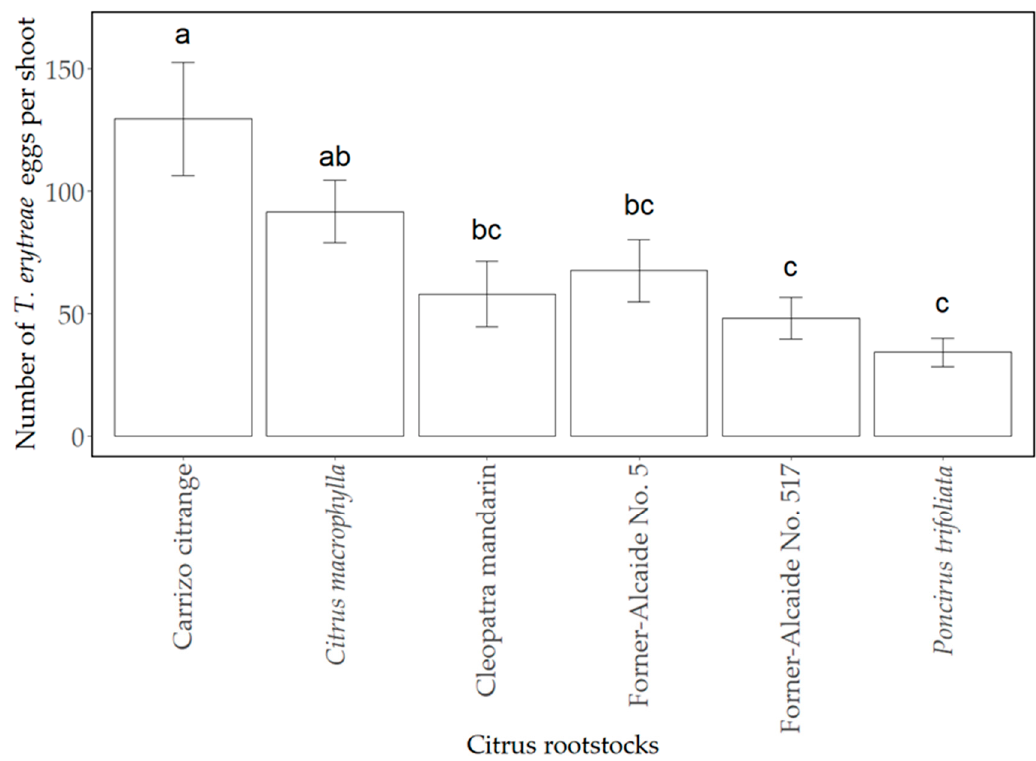
Figure 2. Mean of T. erytreae eggs per shoot ± standard error (SE) in the different non-grafted rootstocks tested after the 72-h no-choice laboratory trial. Values in columns with different letters indicate statistical differences among the rootstocks by LSD-Fisher test ( p < 0.05). Poncirus trifoliata : Poncirus trifoliata (‘Flying Dragon’). Table 1. Mean of T. erytreae adults survival (%) ± standard error (SE) in the six different rootstocks assayed for the different assessment periods.